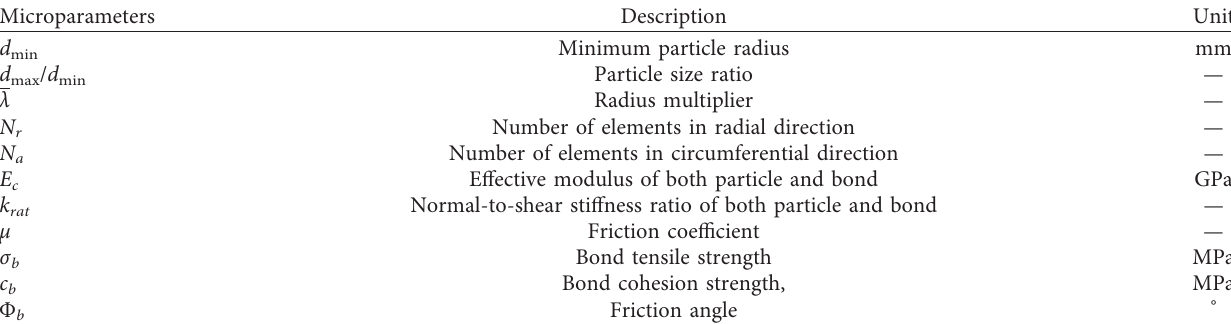
Table 5: Microparameters of